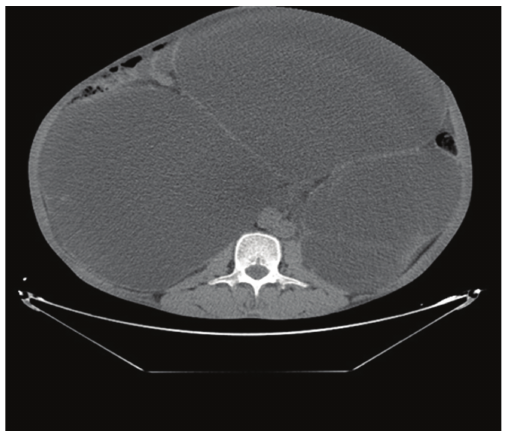
Figure 1: Abdominal CT scan showing massively enlarged bilateral kidney with pressure e ff ect over the bowels.